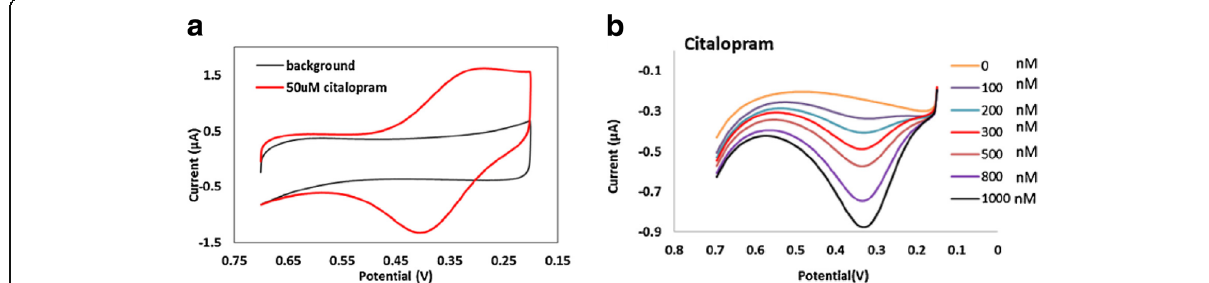
Fig. 12 (Left) CVs of 0 and 50 μ M citalopram and (right) stripping voltammetry of citalopram ranging from 0 to 1000 nM. (Reprinted with permission from Reference Izadyar et al. 2016). © 2016 Elsevier